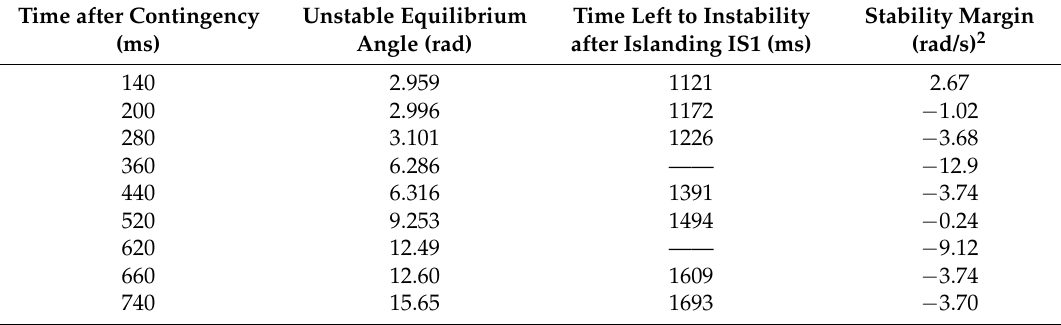
Table 2. Transiently stable indications in the island containing G2 and G3 after islanding strategy IS1 was